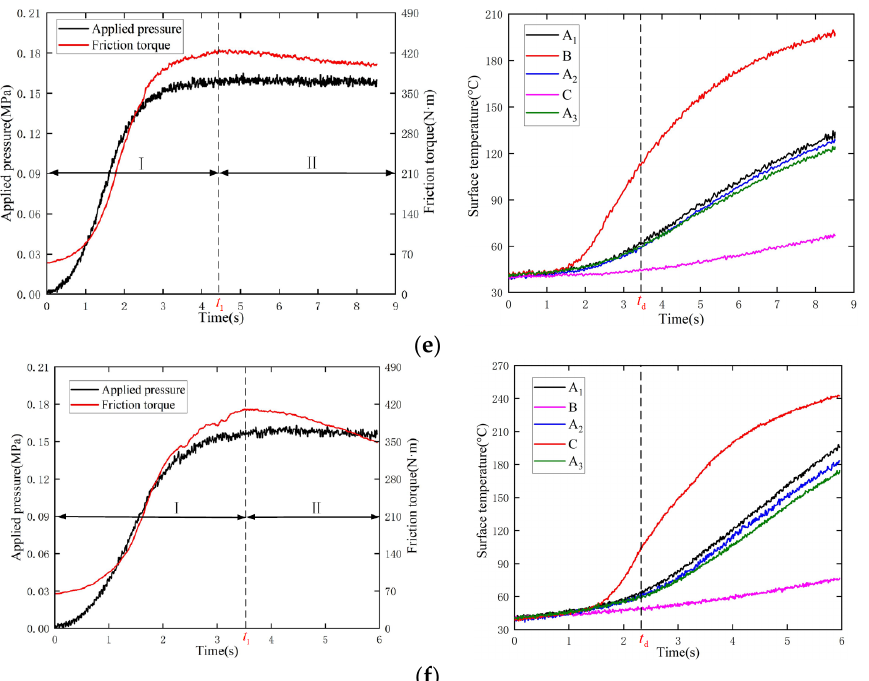
Figure 7. Experimental results for the clutch thermodynamic characteristics. ( a ) Test 1; ( b ) Test 2; ( c ) Test 3; ( d ) Test 4; ( e ) Test 5; ( f ) Test 6.